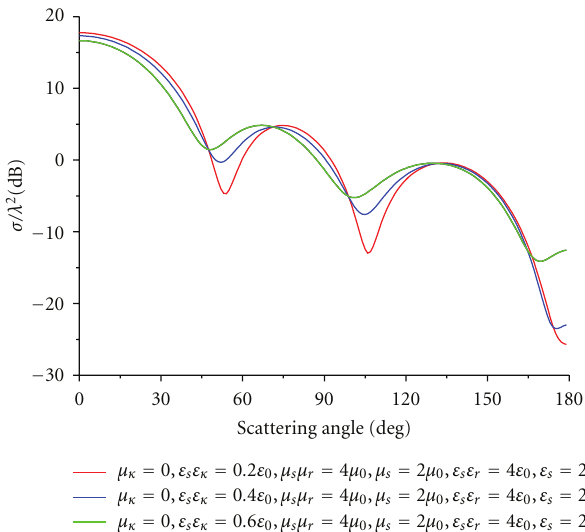
Figure 1: Normalized Radar cross-section (RCS) values versus the scattering angle. Di ff erent gyroelectric influence is considered. Here, k 0 r = π .